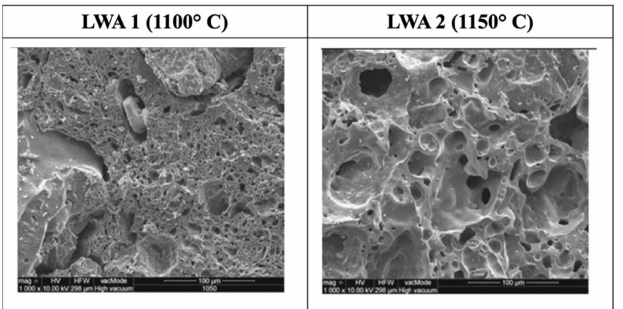
Figure 4. SEM of sintered lightweight aggregate made up of clay and sewage sludge at 1100 ◦ C and 1150 ◦ C